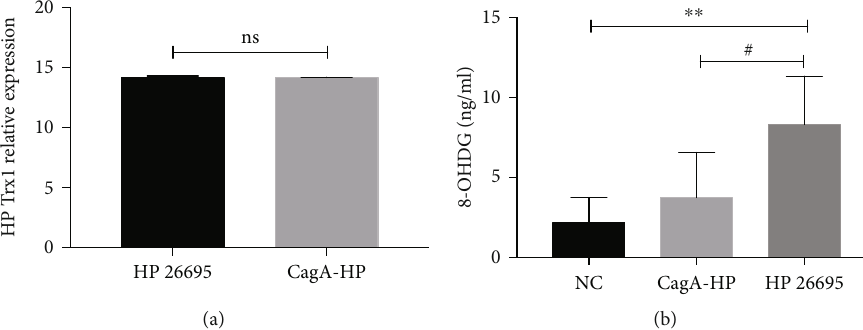
Figure 6: The CagA gene cannot a ff ect the Trx1 expression in HP. (A) The HPTrx1 expression of HP26695 and the CagA knockout HP was analyzed by real-time PCR. (b) The 8-OHDG expression of HP2695 and the CagA knockout HP was analyzed by ELISA. NC means uninfected control group, HP26695 means the Standard HP ATCC26695 strain, and CagA-HP means the CagA-knockout HP ATCC 26695 strain. ns represents nonsigni fi cance, ∗∗ P < 0 : 01 , and # P < 0 : 05